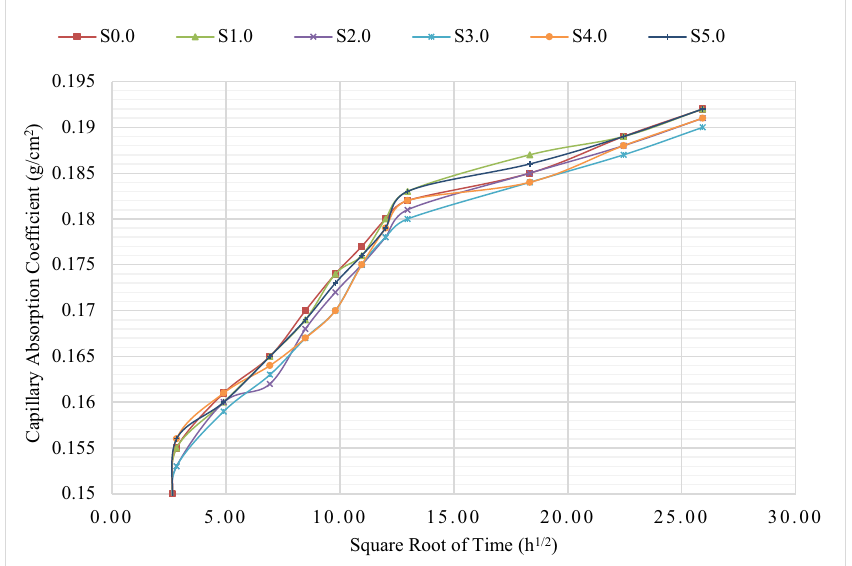
Figure 12: Capillary absorption of SSHWC